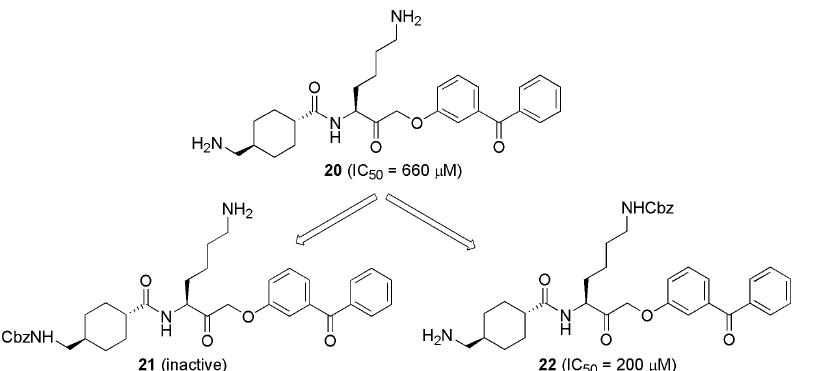
Table 6. Inhibitory activity of compounds 23 – 26 [30] against various proteases. Figure 1. Confirmation of which amino acid interacts with Asp at the S1 site by using two derivatives ( 21 [29] and 22 [29] ) from 20 [29]. Comp.